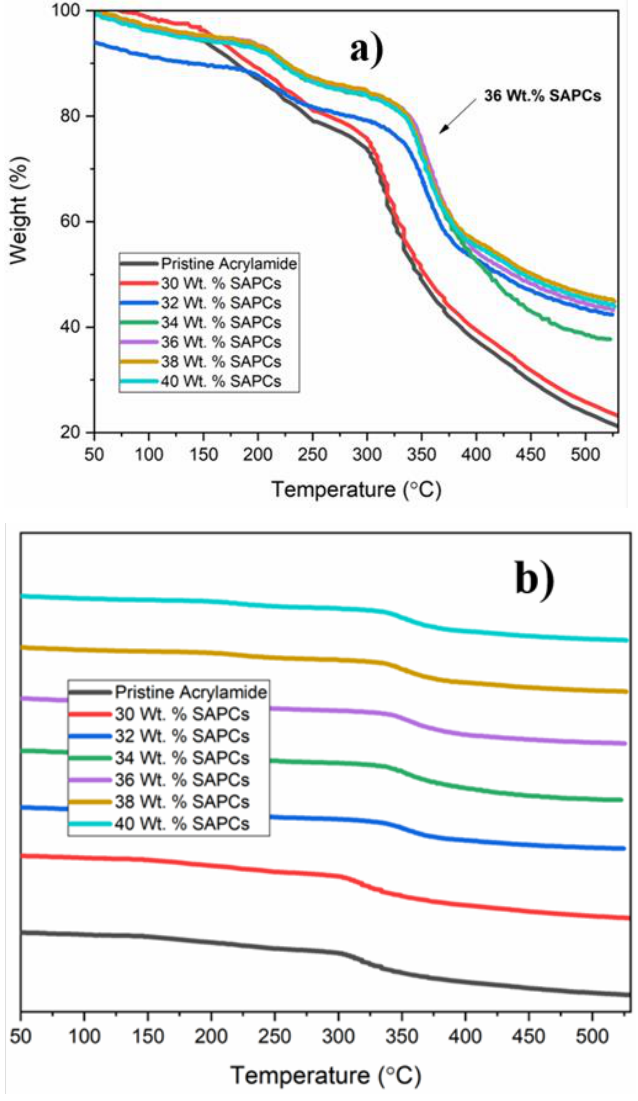
Fig. 2. (a) Weight loss spectra of composite (SAPCs) with different wt. %, (b) Stacked of